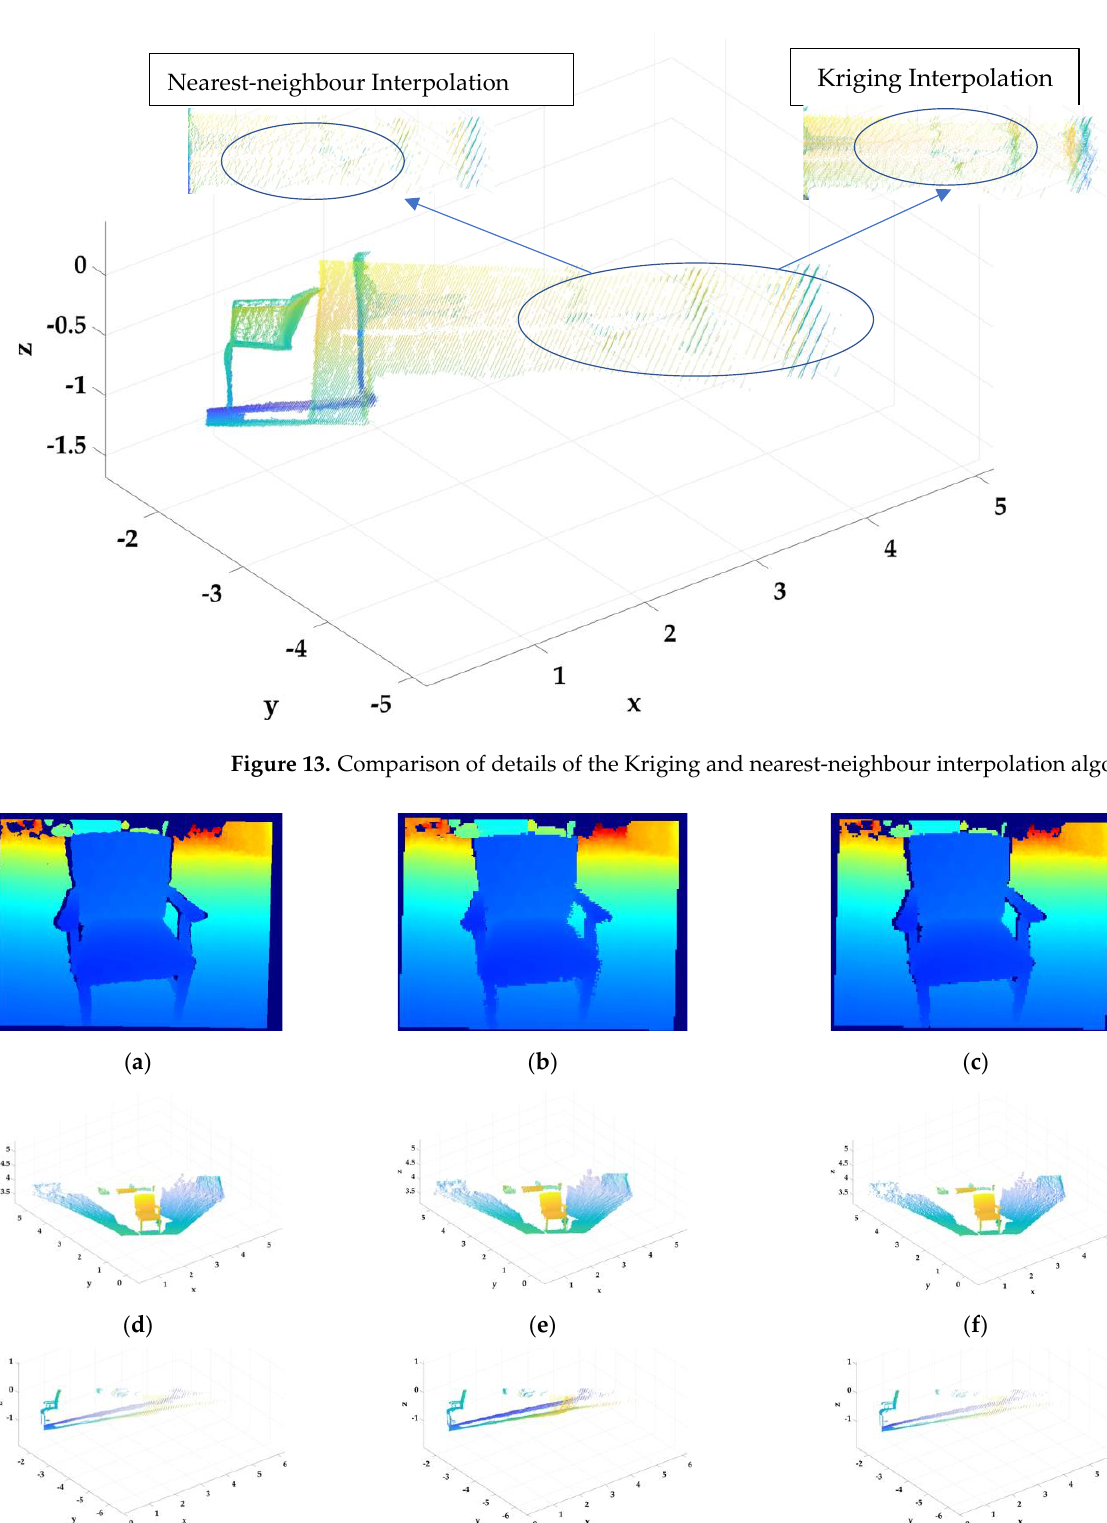
Figure 14. Validation of fractional−order differential Kriging interpolation super−resolution model (dataset no. 05989). ( a, d, g ) Original depth images; ( b, e, h ) Outputs of fractional−order differential Kriging interpolation super−resolution model ( 𝜈 = 0.6, PSNR = 34.459 dB); ( c, f, i ) Outputs of nearest- neighbour interpolation super−resolution model (PSNR = 25.503 dB).